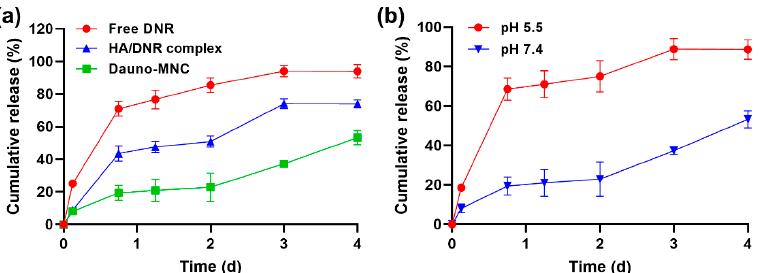
Figure 4. ( a ) Cumulative drug release profiles of Dauno-MNC, HA/DNR complex and free DNR in 10 mM PBS (pH 7.4) over 4 days. ( b ) Cumulative drug release profiles of Dauno-MNC at pH 5.5 and 7.4. Mean ± SD ( n = 3).